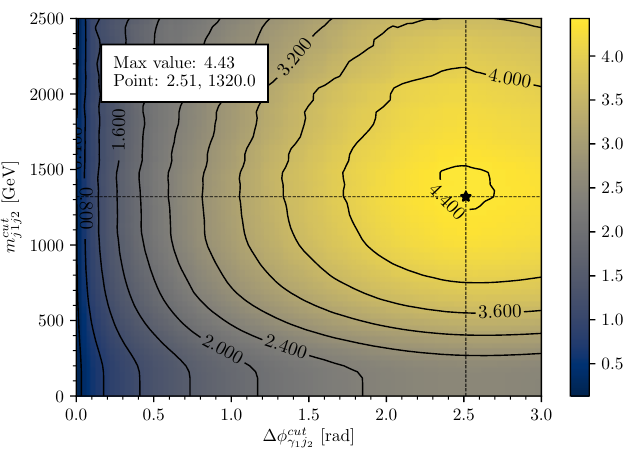
Figure 10 . Dependence of the NLO signi(cid:12)cance EW = p QCD calculated with luminosity L = 1 fb (cid:0) 1 on the cuts m j > m cut and (cid:1) (cid:30) j < (cid:1) (cid:30) cut . In addition, the other default cuts are j 1 j 2 j 2 (cid:13) 1 1 j 2 2 (cid:13) 1